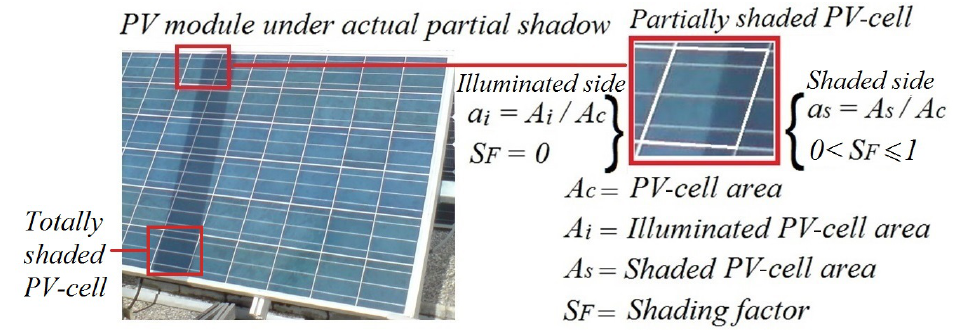
Figure 3. Partially shaded